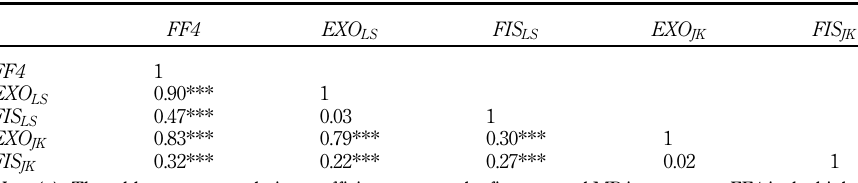
Table 2. Correlation